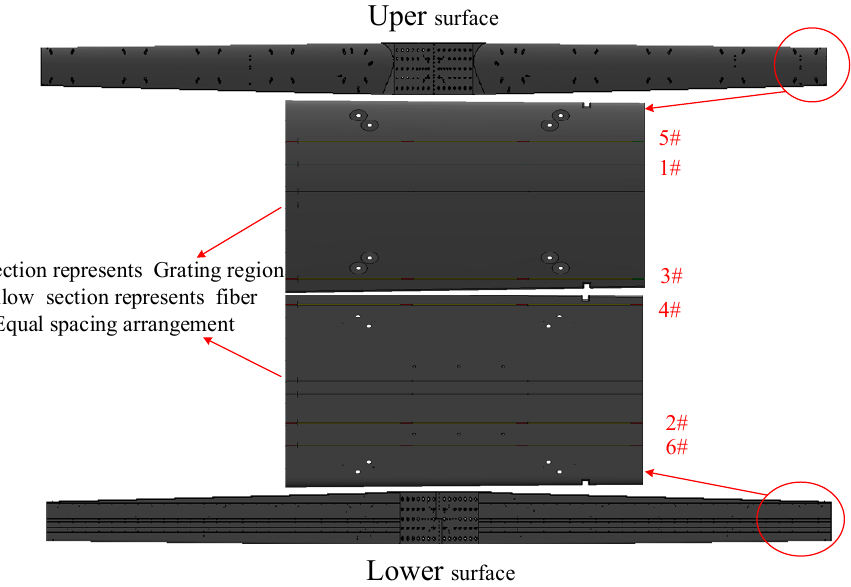
Figure 11. Schematic diagram of overall installation of fiber grating.